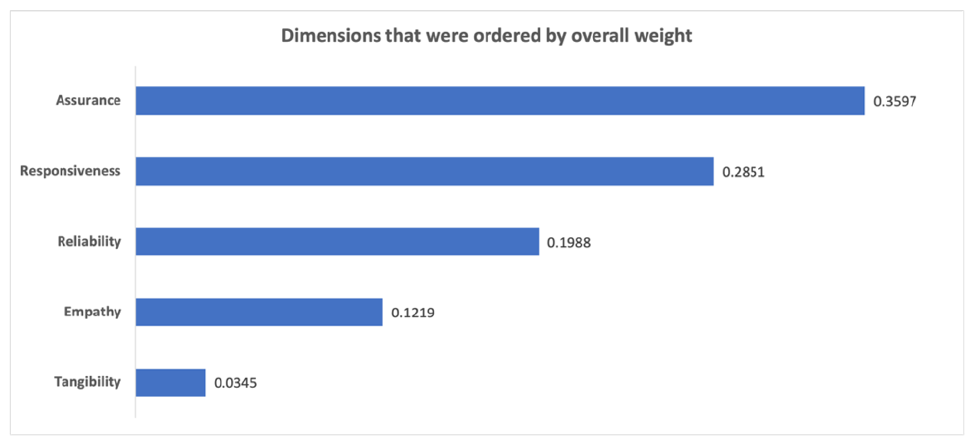
Figure 5. The overall weight and ranking of dimensions in FANP model.